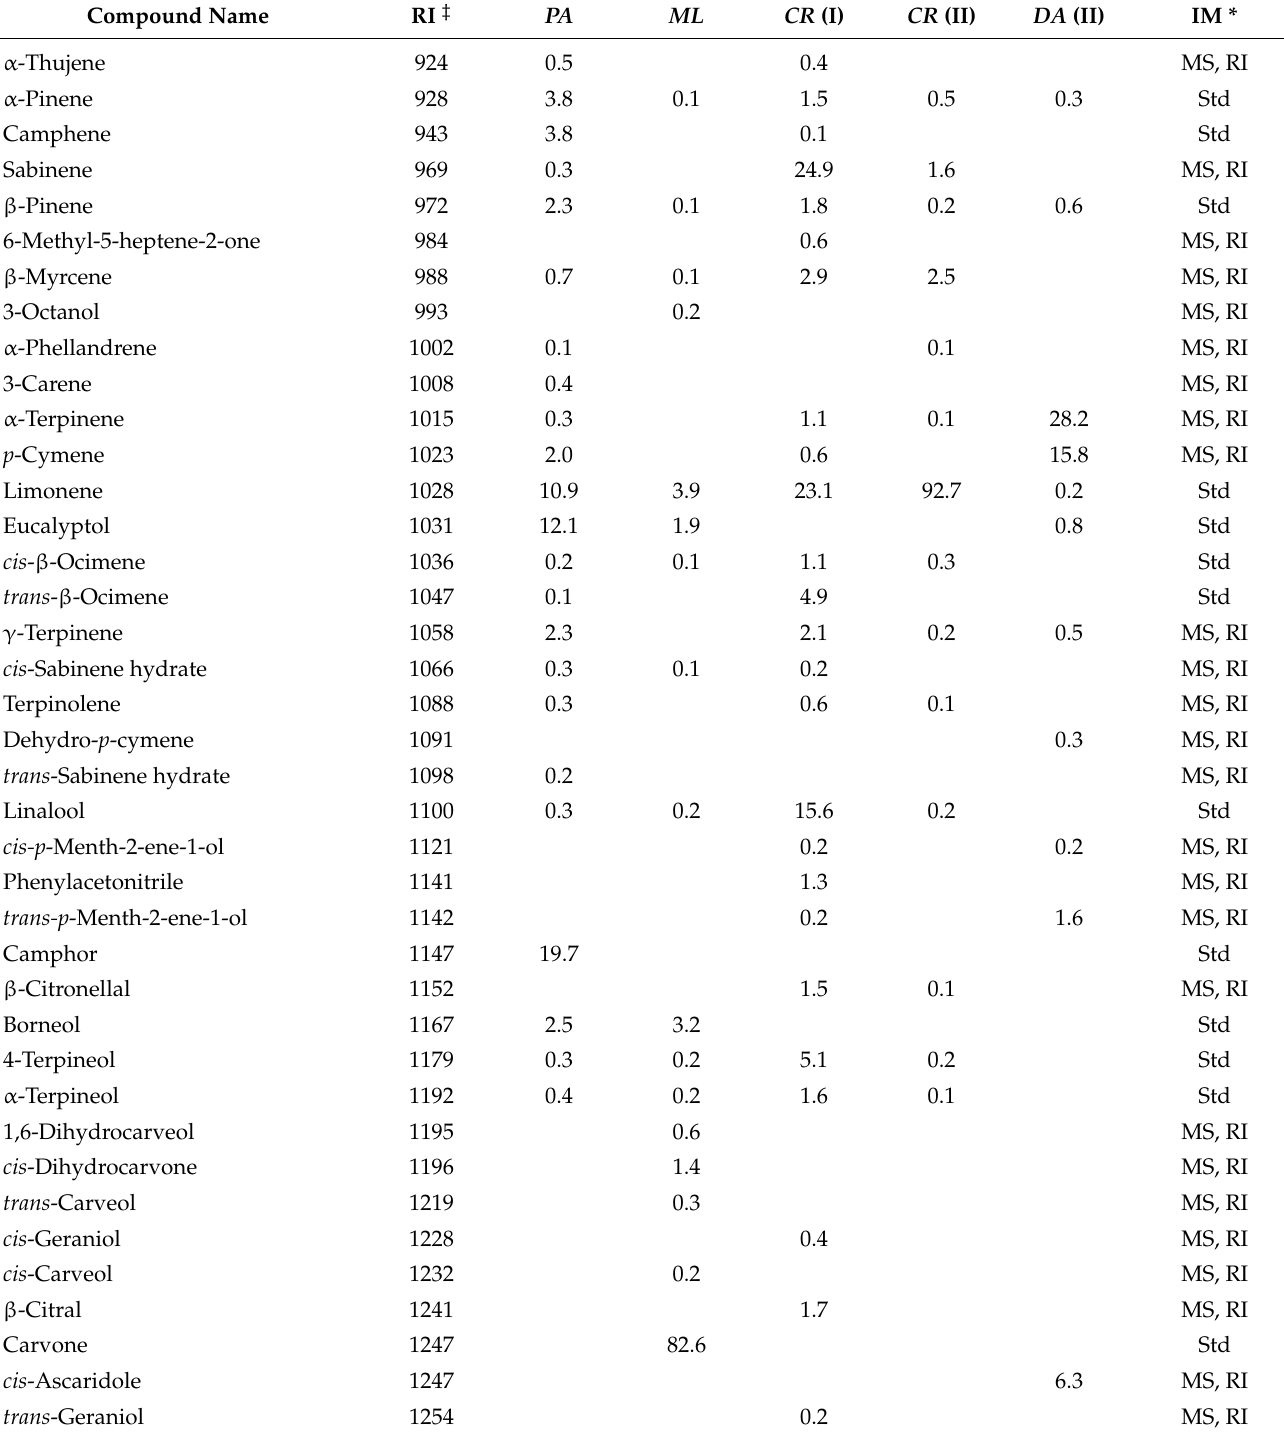
Table 2. Chemical composition of plant essential oils based on total ion chromatogram of